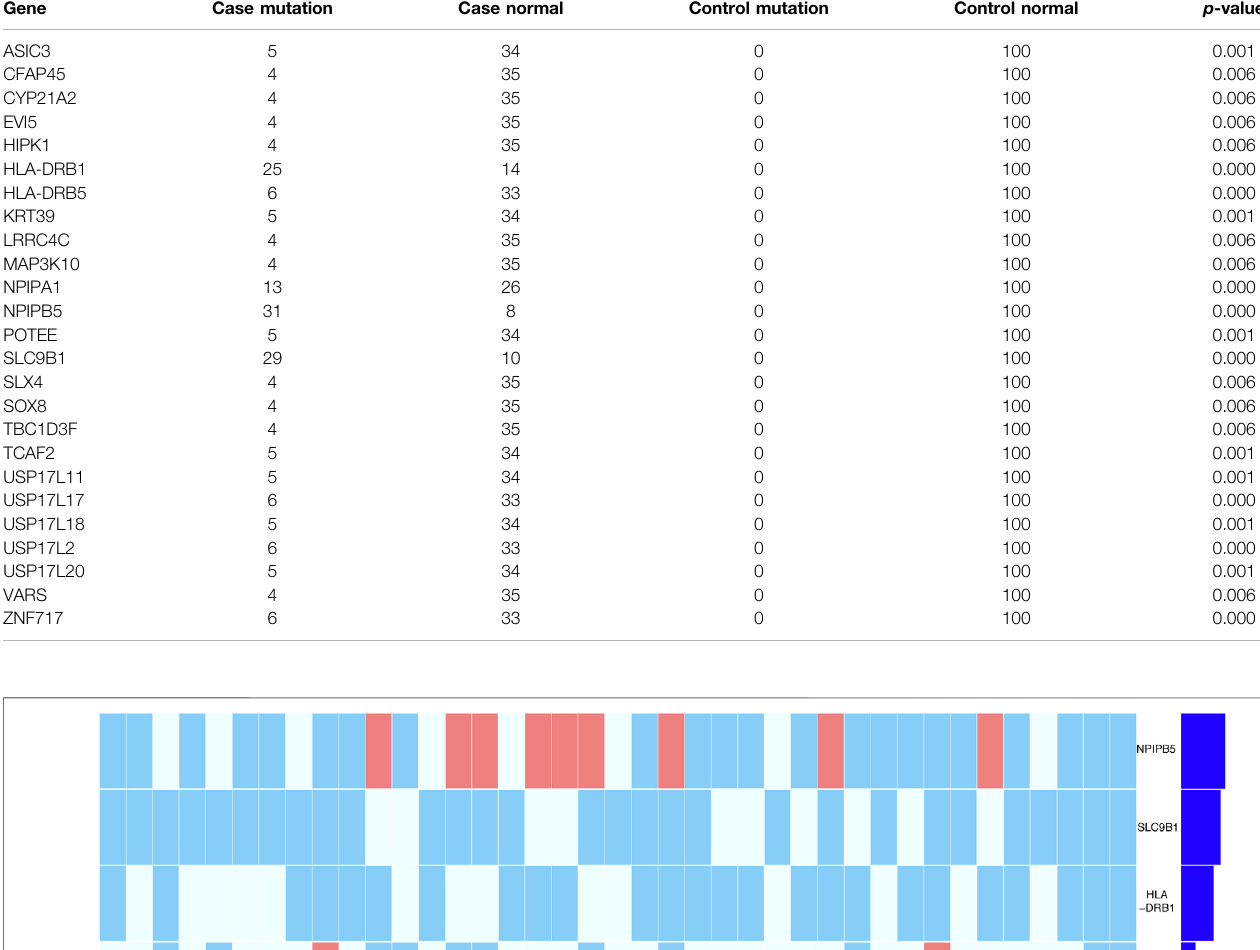
TABLE 3 | Gene fi ltering based on Burden analysis.